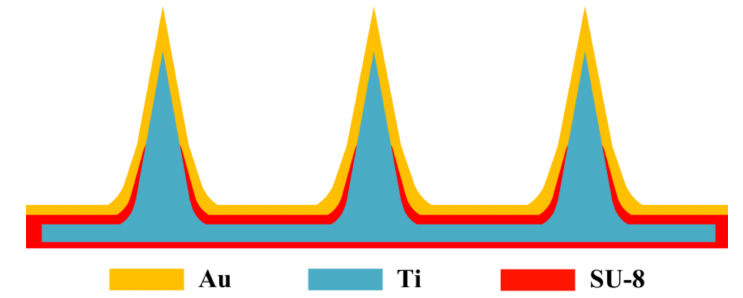
Figure 2. Structural diagram of the CMAE.